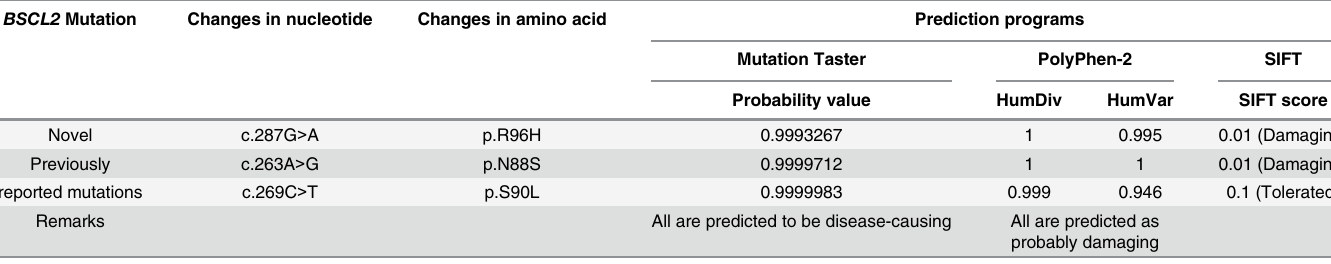
Table 1. Deleterious consequences of the BSCL2 variants predicted by in silico